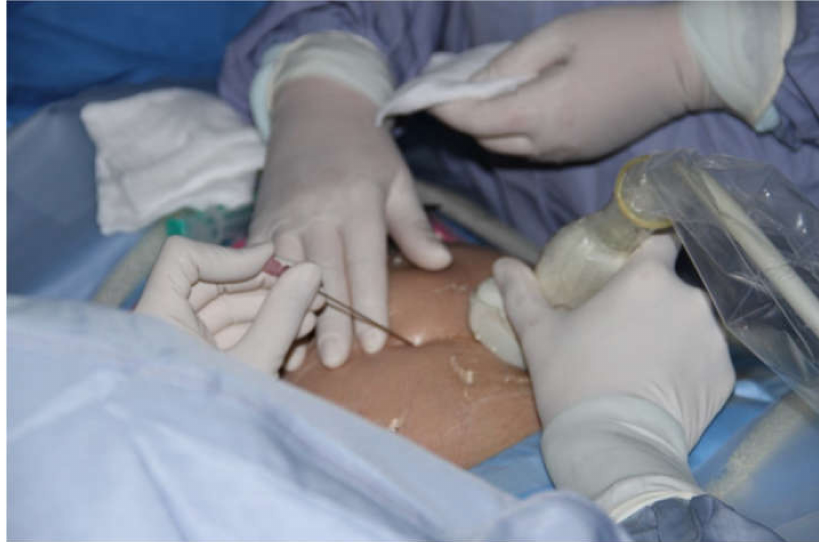
Figure 3. The technique of performing all cardiac interventional procedures. Antiseptic operating field, transducer covered by antiseptic sleeve. The obstetrician holds the transducer in the right hand and the needle in the left